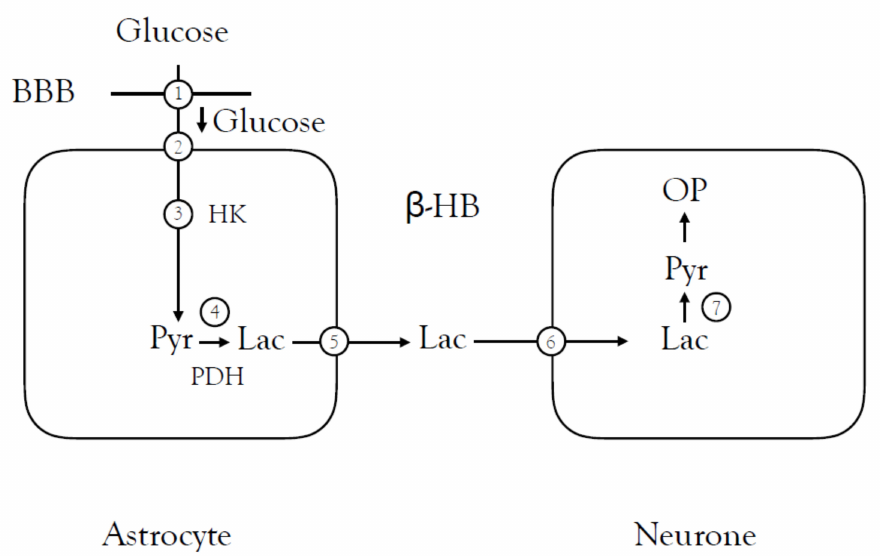
Figure 3. Disruptions in lactate shuttling in Alzheimer’s disease. In mouse models of AD, there is a generalised decrease in glucose uptake at 6 to 9 month of age, which was sustained at 12 to 15 months, facilitated by down-regulation of the blood brain barrier (BBB) Glut1 (1) and the neuronal Glut3 (2) transporters. The levels of hexokinase expression (3) were reduced but PDH activity (4) was increased, which reduced conversion of pyruvate to lactate. The expression of the astrocytic MCT4 (5) and the neuronal MCT2 (6) were down regulated, but the levels of the ketone body β -hydroxybutyrate ( β -HB) were increased. The lactate is converted to pyruvate